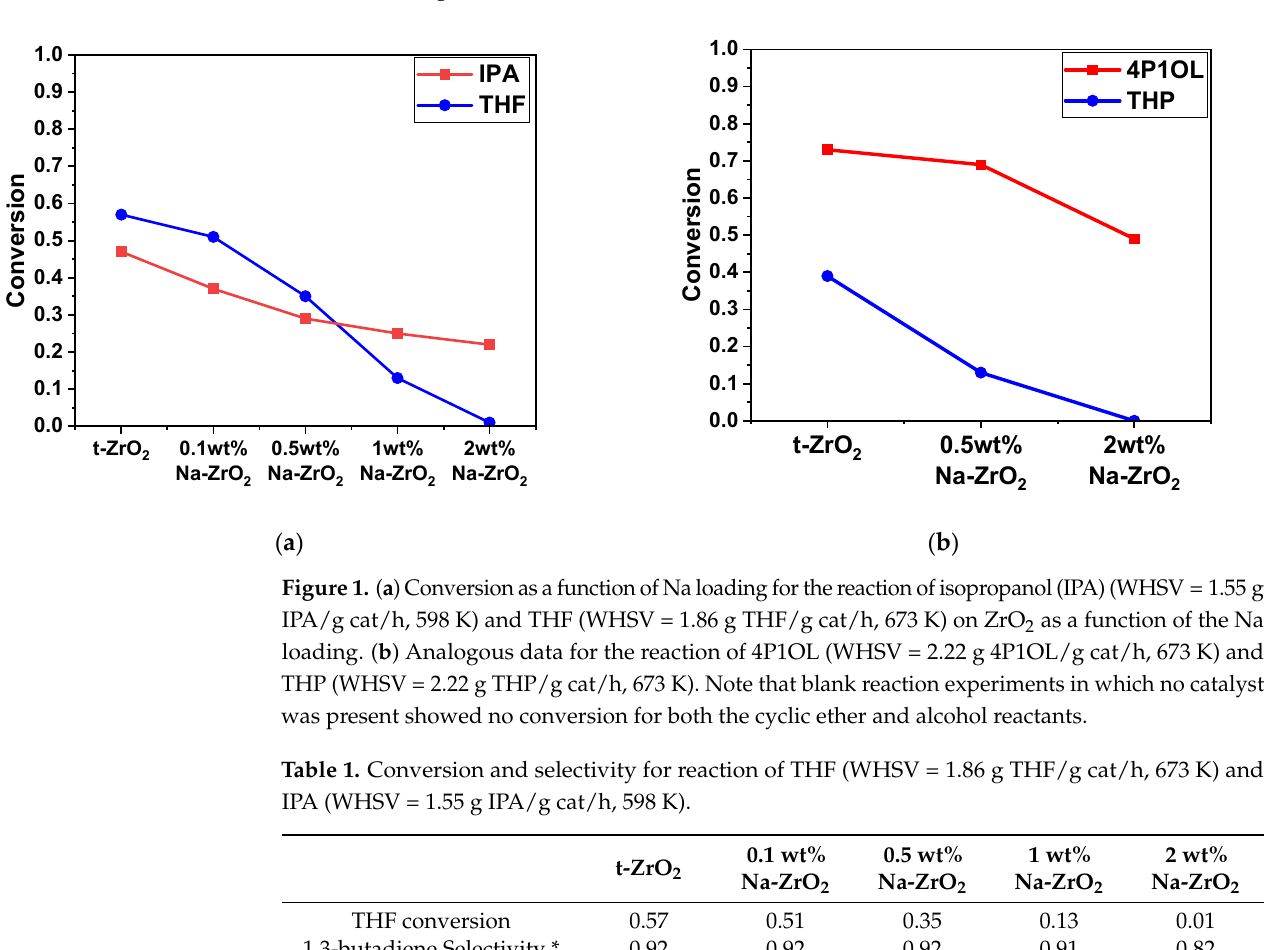
Table 1. Conversion and selectivity for reaction of THF (WHSV = 1.86 g THF/g cat/h, 673 K) and IPA (WHSV = 1.55 g IPA/g cat/h, 598 K).